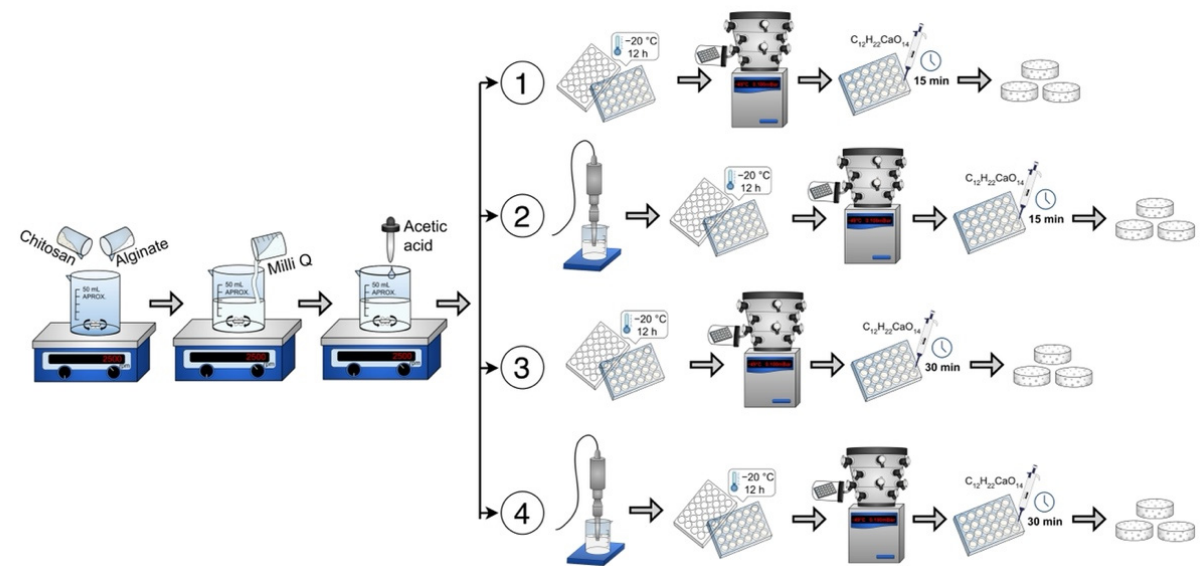
Figure 1. Four scaffold preparation methods: Method 1 (without sonication), Method 2 (with sonication), Method 3 (longer crosslinking time) and Method 4 (with sonication and longer crosslinking time).